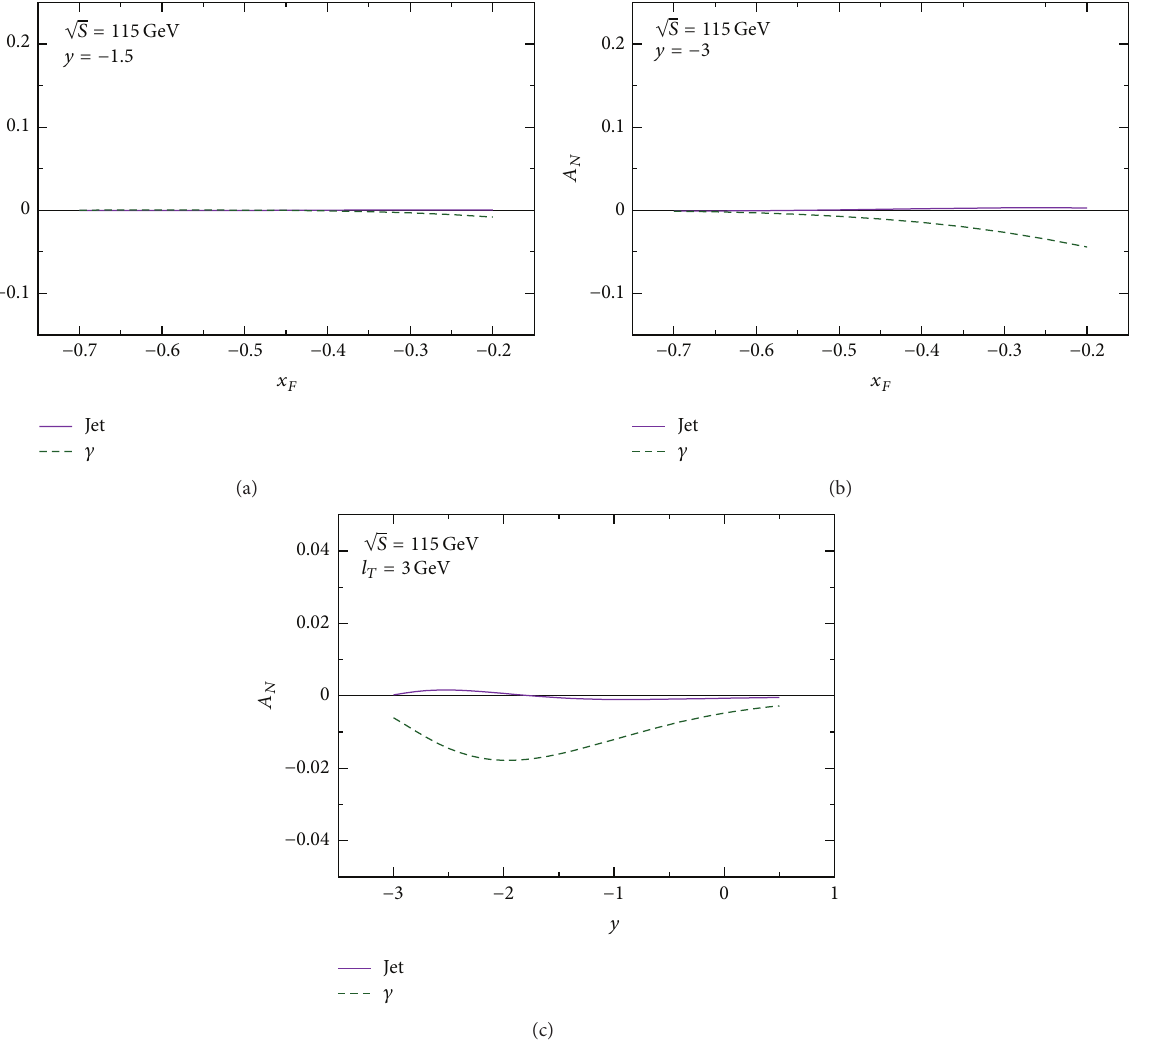
Figure 3: 𝐴 𝑁 versus 𝑥 𝐹 at fixed 𝑦 = −1.5 (a) and 𝑦 = −3 (b) and 𝐴 𝑁 versus 𝑦 at fixed 𝑙 𝑇 = 3 GeV (c). All plots are at √𝑆 = 115 GeV for jet/photon production at